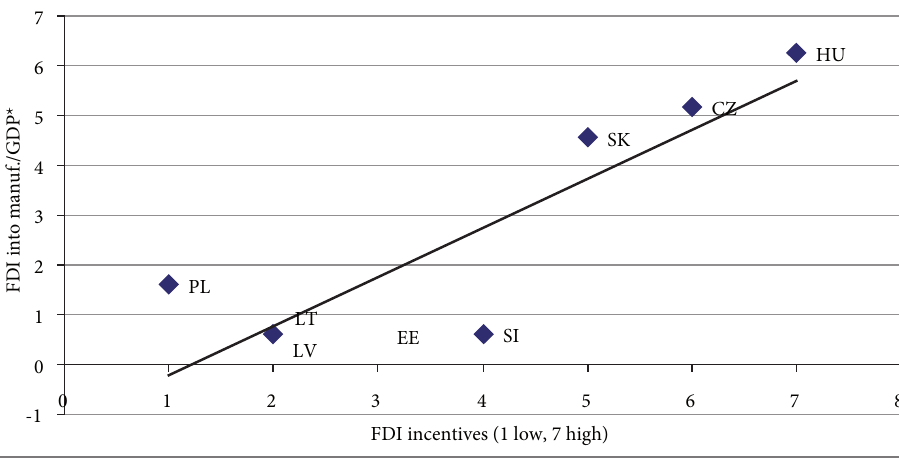
Fig. 3. Impact of FDI incentives on German investments into production units *German total FDI stock into production units (in mill. Euros) as share of total GDP for each country (in mill. Euros), year